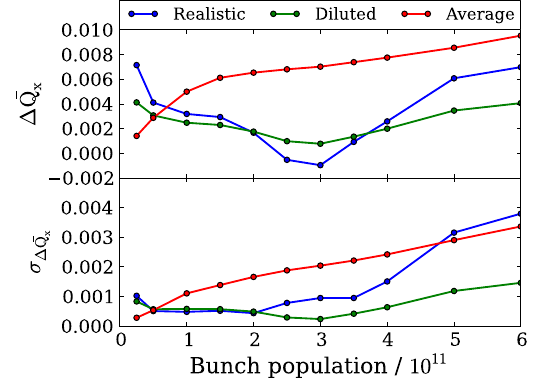
FIG. 14. The vertical tune shift (upper graph) and its standard deviation (lower graph) as a function of bunch population in a dipole magnet. The blue curve shows the results for a nonuniform cloud. The green curve shows the results for the uniform, diluted cloud. The red curve corresponds to the uniform cloud. The SEY ¼ 1 . 4 . is δ max